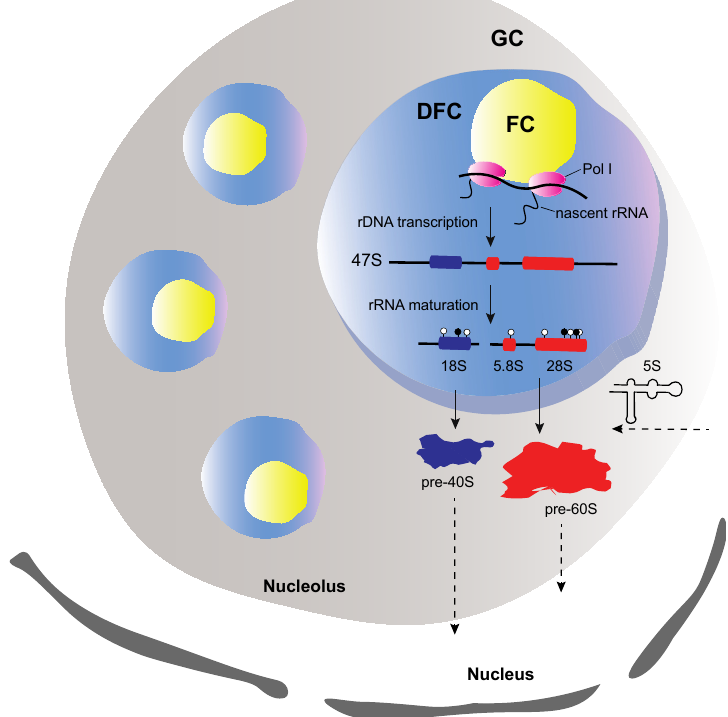
Figure 1. Illustration of the structure a well-defined nucleolus. The nucleolus consists of three sub-compartments, the fibrillar center (FC), the dense fibrillar center (DFC) and the granular component (GC). FC is surrounded by DFC and both are embedded in GC. At FC borderline the rDNA transcription occurs. The early and late steps of the rRNA processing occur, respectively, at DFC and GC. The early assembly steps occur in GC, where the precursors of 40S (pre-40S) and 60S (pre-60S) subunits are formed, as soon as the 5S rRNA enters the nucleolus. Pol I refers to RNA polymerase I, white and black circles refer to uridylated and methylated modified nucleotides, respectively. Arrows with dashed lines indicate transport from or to the nucleolus.